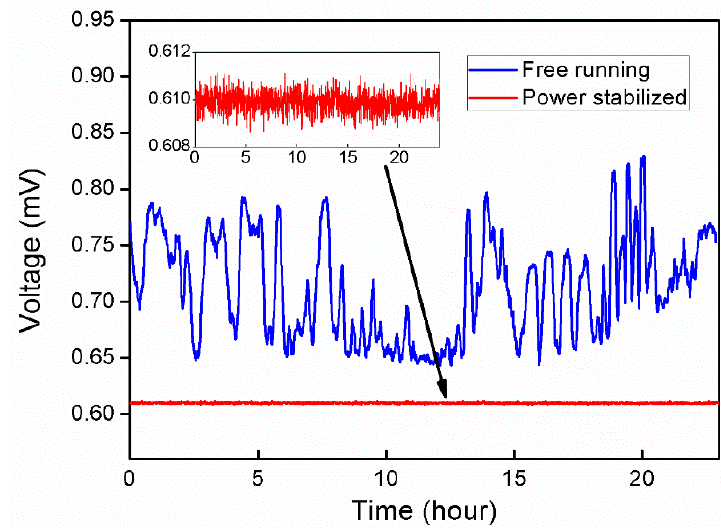
Figure 10. Power both of the Raman laser in free running (upper) and in stabilization (lower).